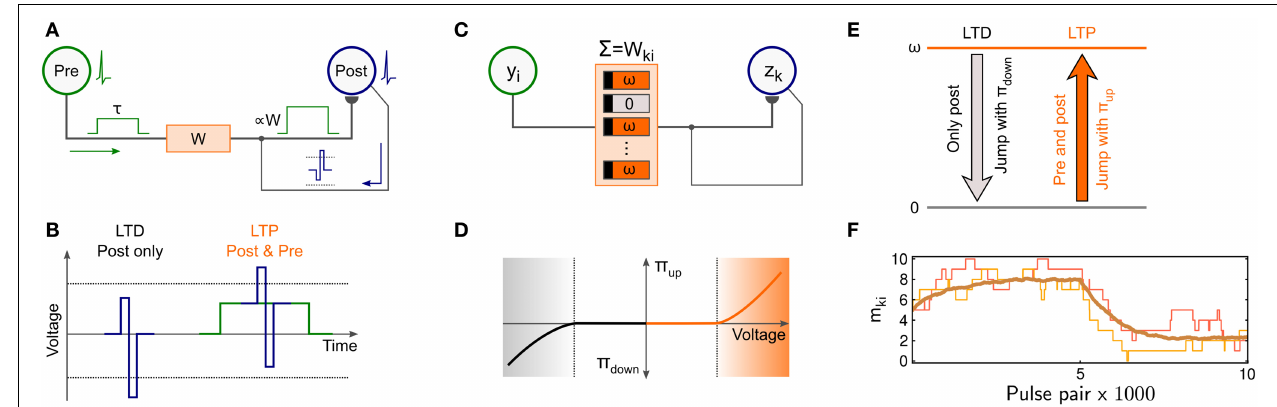
FIGURE 1 | Compound memristive synapse model with stochastic memristors. (A) STDP pulsing scheme. Input spikes elicit a rectangular voltage trace (green, left) that is sent to the presynaptic terminal of the memristor synapse. Post-synaptic spikes elicit a brief voltage pulse (blue) which is sent back to the synapse. (B) Solitary postsynaptic spikes trigger LTD since the voltage exceeds the lower threshold of the memristor. Simultaneous pre- and postsynaptic spikes trigger LTP since the voltage exceeds the upper threshold. (C) Compound memristive synapse model. A synapse is composed of M bistable memristors operating in parallel. Each memristor can either be active (weight ω ) or inactive (weight 0). The total synaptic weight W ki between input neuron y i and network neuron z k is the sum of the individual memristor weights. (D) Bistable memristors switch